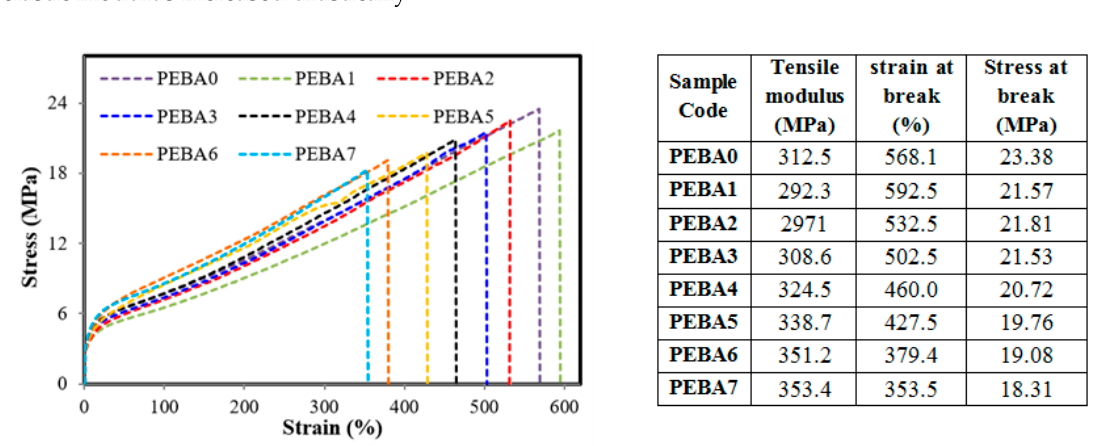
Figure 9. Stress-Strain curves of the synthesized membranes .